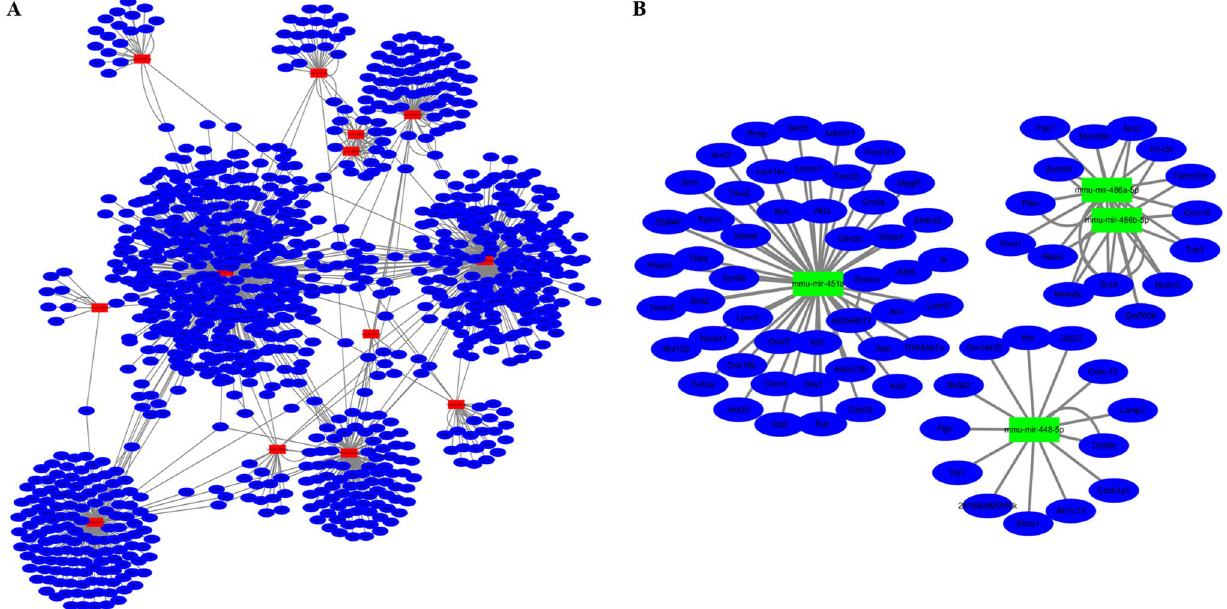
Figure 3. Predicted target genes of the DE-miRNAs. ( A ) Upregulated DE-miRNA-target gene network constructed using miRNet. The red rectangles represent the upregulated DE-miRNAs, and the blue ellipses represent the target genes. ( B ) Downregulated DE-miRNA-target gene network constructed using miRNet. The green rectangles represent the downregulated DE-miRNAs, and the blue ellipses represent the target